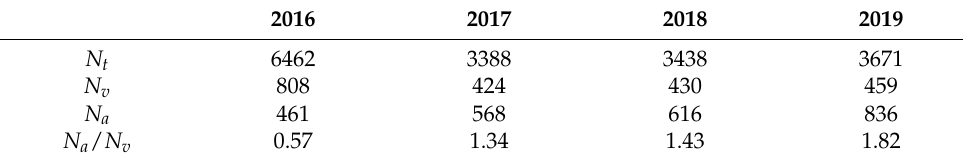
Table 2. The statistical results for each subdataset.